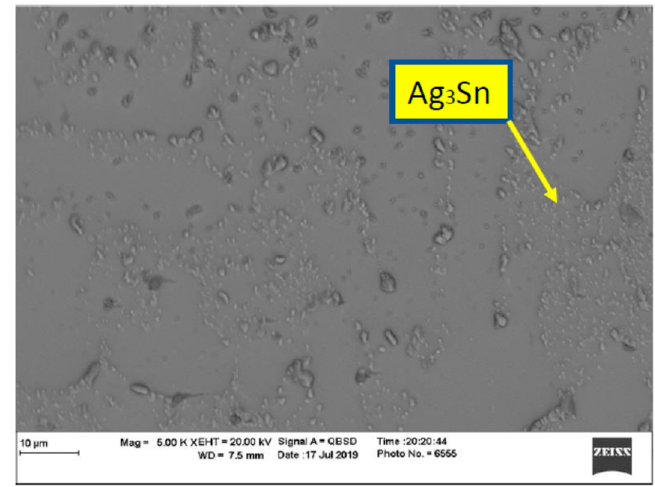
Figure 6. Microstructure of SAC305 thermally aged at 150 ◦ C for 100 h.